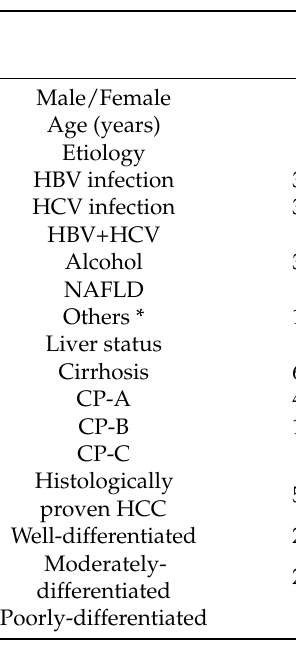
Table 2. Comparison between patients with DNHC and other